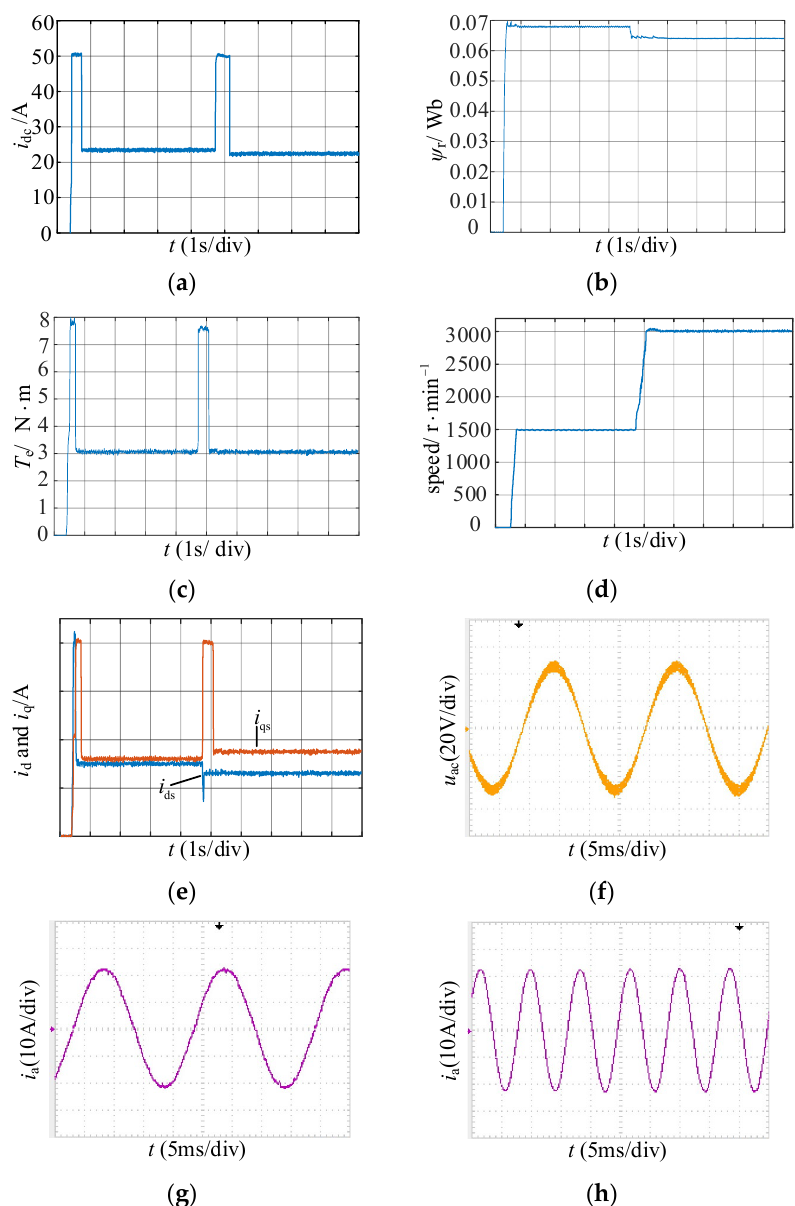
Figure 21. Experimental waveforms under acceleration with load of 3 N · m: ( a ) DC-link current; ( b ) Rotor flux; ( c ) Torque; ( d ) Speed; ( e ) Stator current in d-q axis; ( f ) Stator voltage of phase-a; ( g ) Stator current of phase-a under speed of 1500 rpm; ( h ) Stator current of phase-a under speed of 3000 rpm.